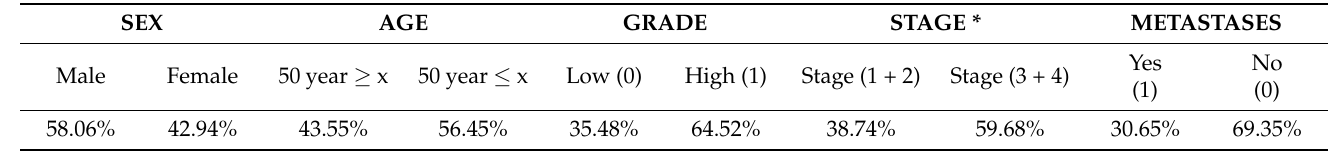
Table 2. Study cohort: patients’ clinicopathological data.